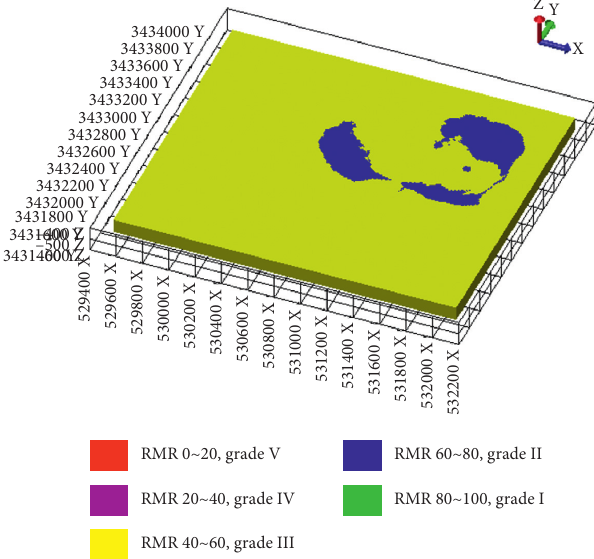
Figure 12: − 560 ∼ − 450m RMR index rock mass classification 3D